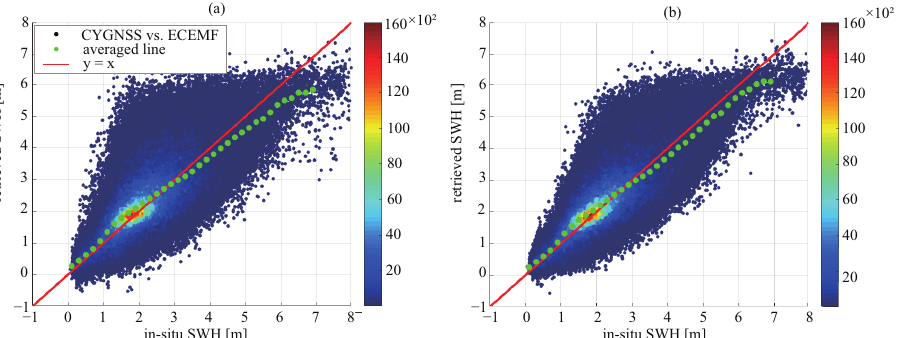
Figure 6. Scatter between retrieved SWH and ECMWF data for ( a ) the third case and ( b ) the fourth case.